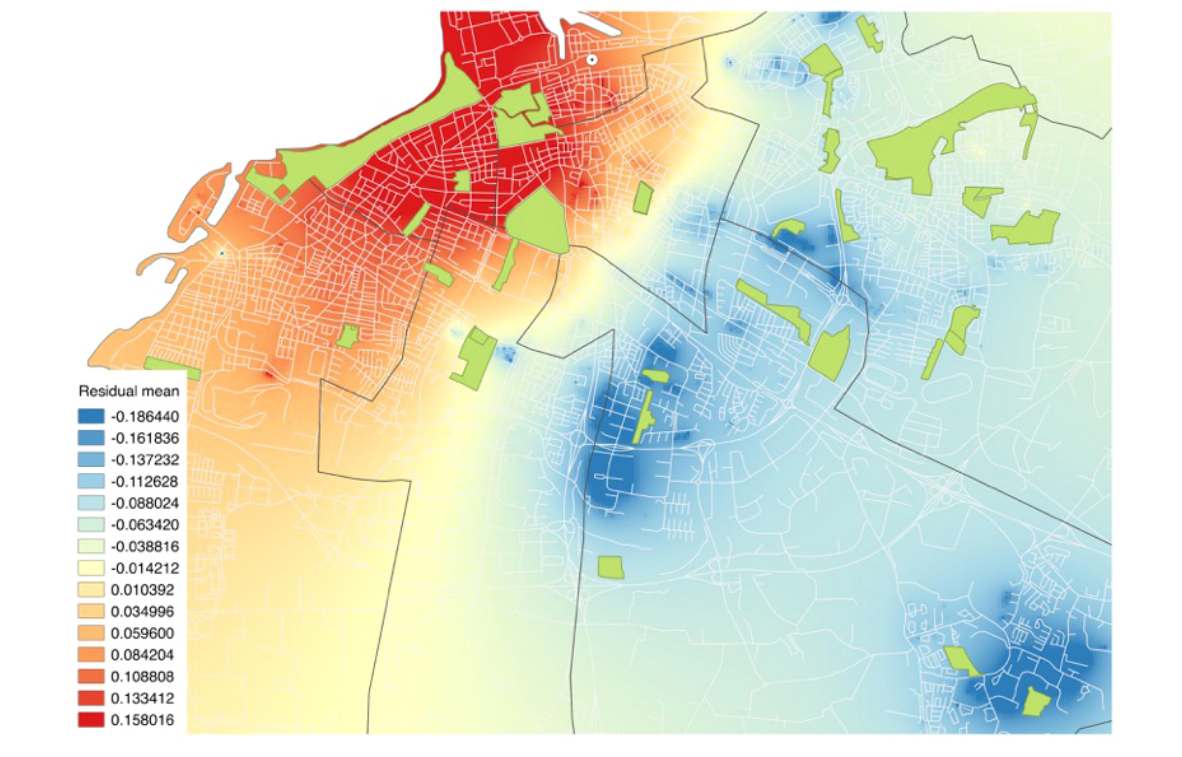
Fig. 2 . Malmö heat map based on residuals extracted from a regression featuring only housing specific characteristics (excluding all neighborhood attributes). Red (blue) areas indicate that properties in that region typically sell at a relatively higher (lower) price. The legend indicates the magnitude of the difference. Taking the exponential of these values we get the percentage relative difference in selling price for the different